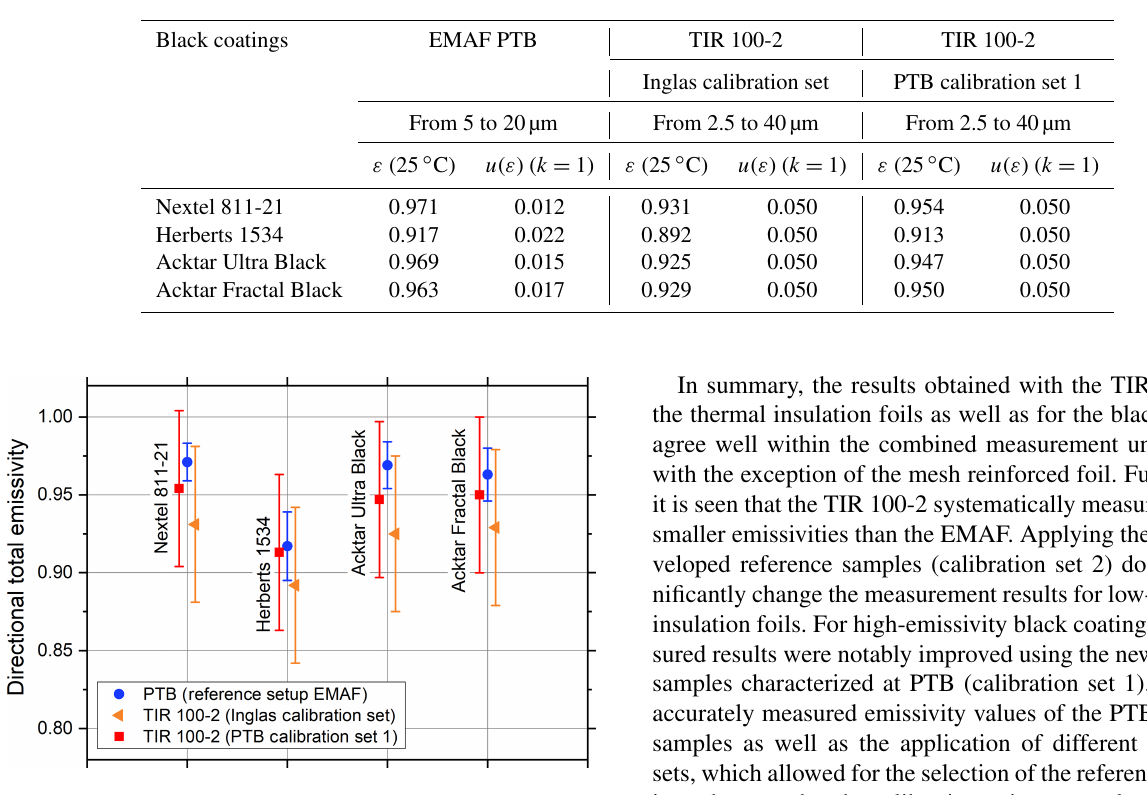
Figure 13. Directional total emissivity of the four black coatings measured by the EMAF at PTB and measured using the TIR 100-2 with the two different calibration